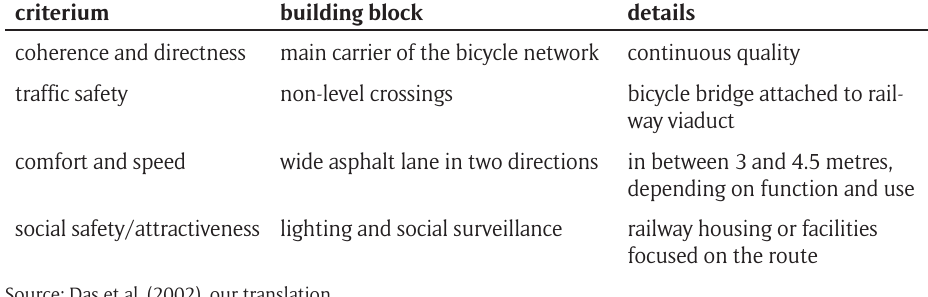
Table 1: Fietsspoor’s preferential